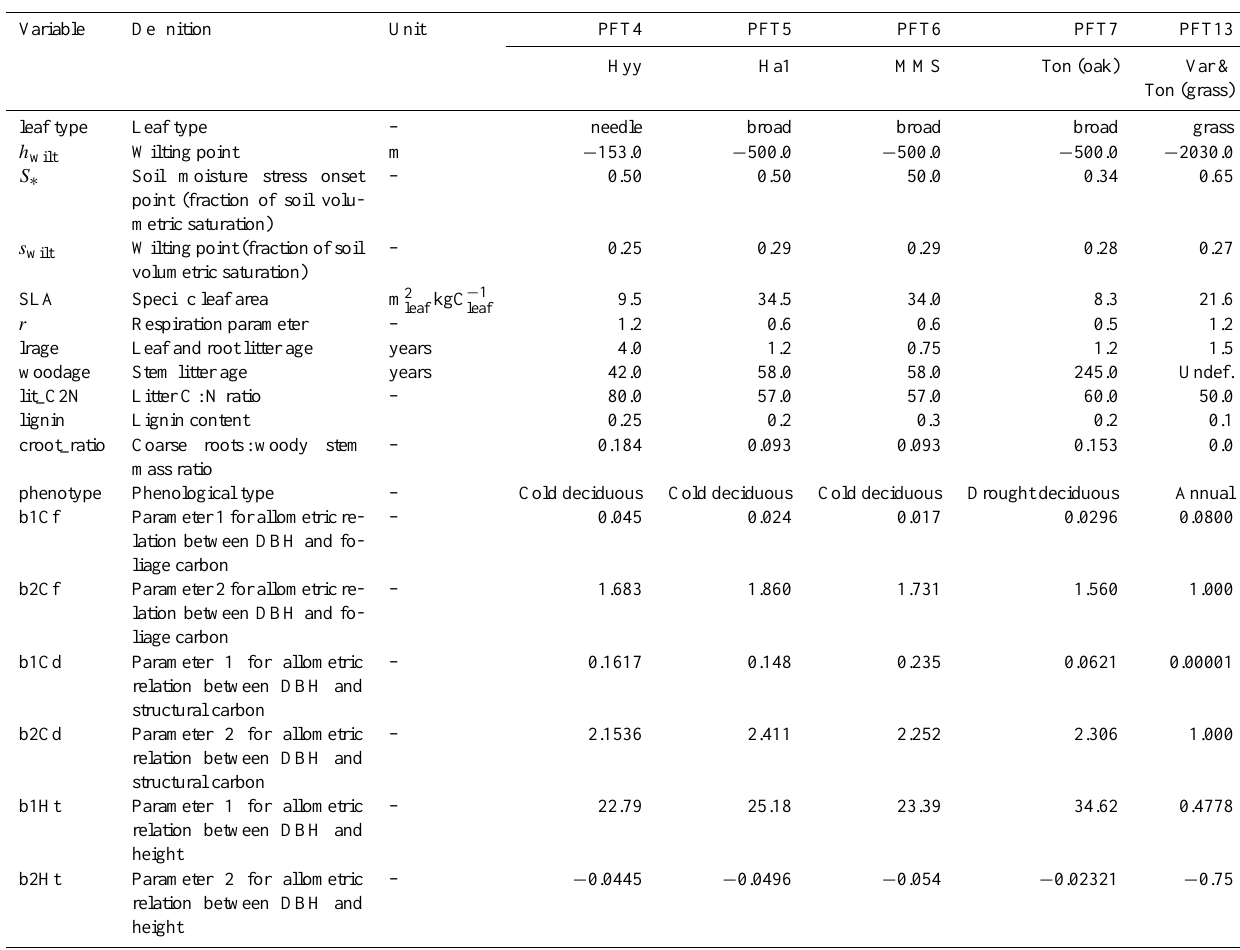
Table D2. Biogeochemical and phenological parameters for Fluxnet sites in this study.